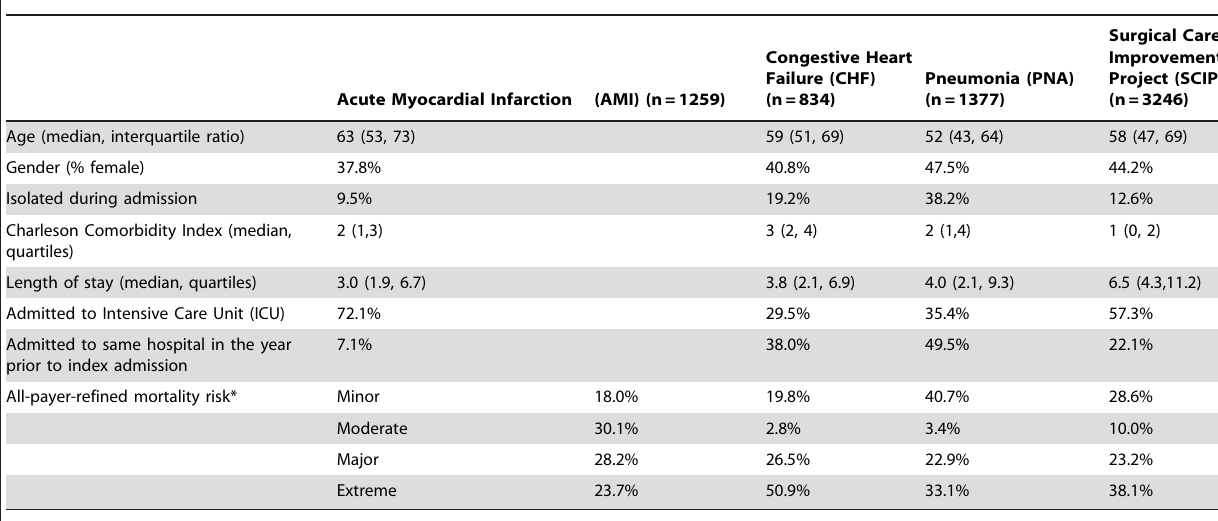
Table 1. Basic admission characteristics for all patients included in each Center for Medicare & Medicaid (CMS) process of care